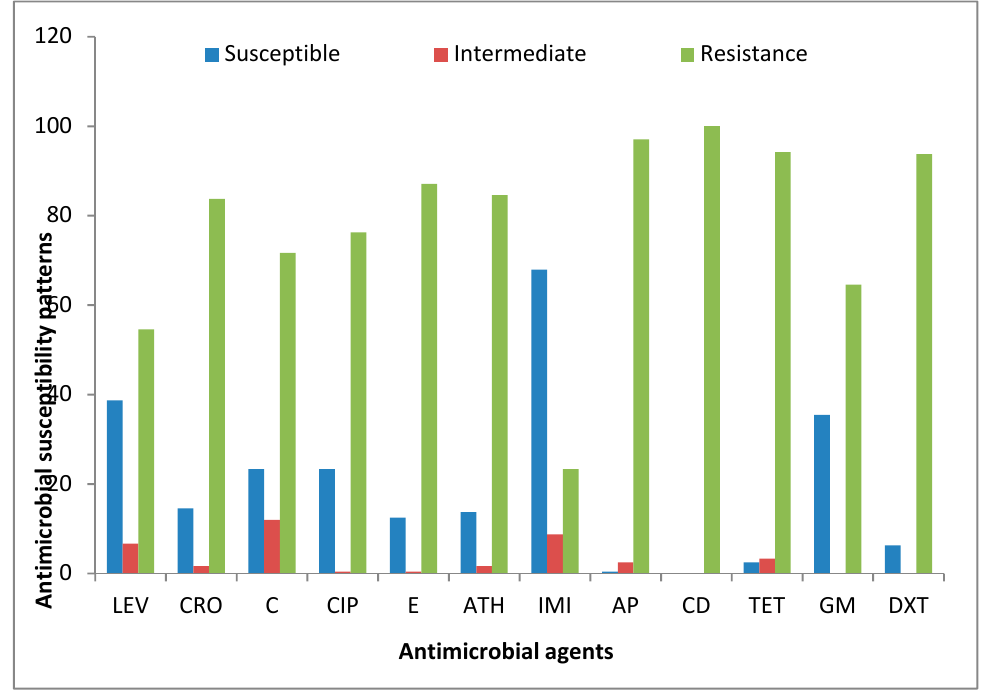
Figure 7. Antimicrobial susceptibility patterns of Campylobacter isolates recovered from meat carcasses sold in Eastern Cape, South Africa. Levofloxacin (LEV), ciprofloxacin (CIP), azithromycin (ATH), imipenem (IMI), ampicillin (AP), clindamycin (CD), tetracycline (TET), ceftriaxone (CRO), chloramphenicol (C), erythromycin (E), gentamicin (GM), and doxycycline (DXT). Table 5. Antibiotic resistance patterns of Campylobacter isolates isolated from meat carcasses. No of Isolates No Multiple Antimicrobial Resistance Profile